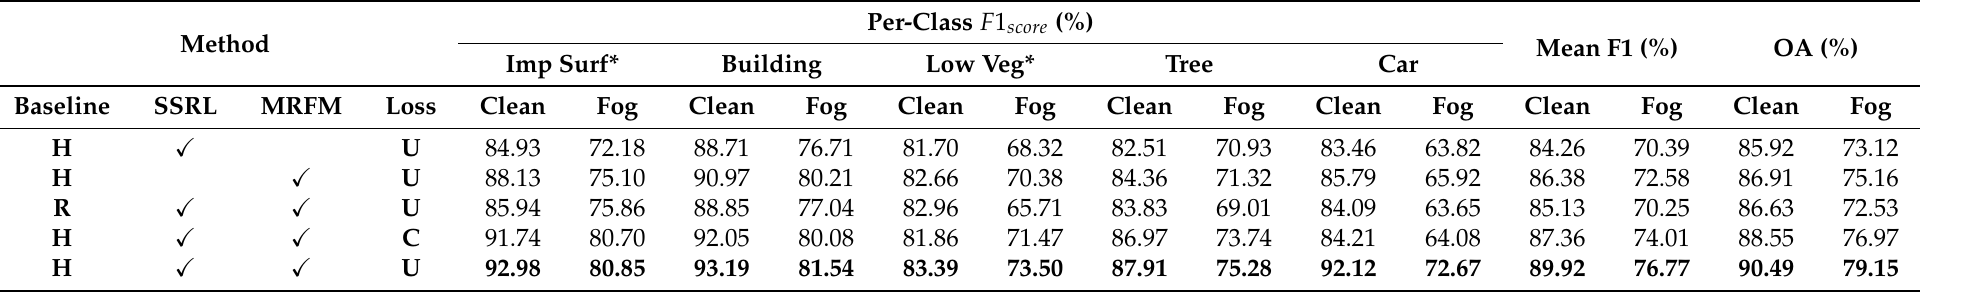
Table 2. Ablation study results with different components integrated based on the clean and fog corrupted variants of the Vaihingen test set. The F 1 score is averaged across five severity levels. The best results are marked in bold.